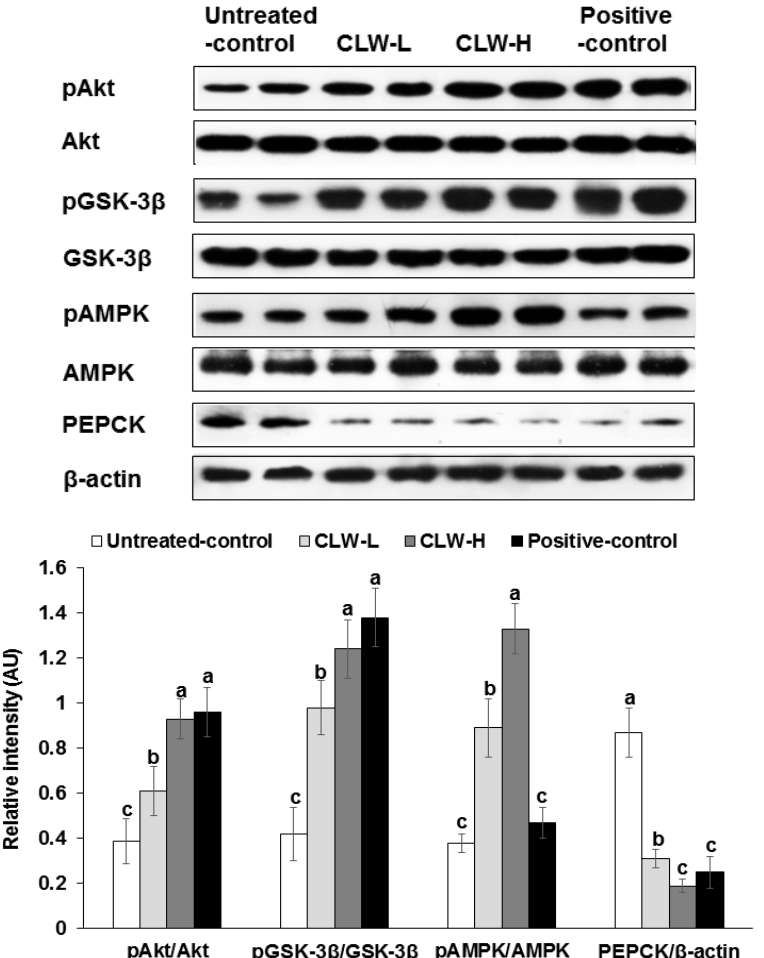
Figure 5. Hepatic insulin signalling. Px rats fed a high-fat diet supplemented with 0.3% lyophilized water extract of C. lanceolata + 0.7% cellulose (CLW-L), 1% lyophilized water extract of C. lanceolata (CLW-H), 1% cellulose (untreated control), or rosiglitazone (20 mg/kg body weight/day) + 1% cellulose (positive control) for 8 weeks. At the end of experiment, the liver was collected and lysed with radioimmunopreciptation assay buffer. The phosphorylation and expression of proteins related to insulin signaling in the liver lysates were measured by western blot analysis. Bars and error bars represented means ± standard deviation ( n = 5). a,b,c Means of the bars without a common letter significantly differ at p < 0.05 by Tukey test.